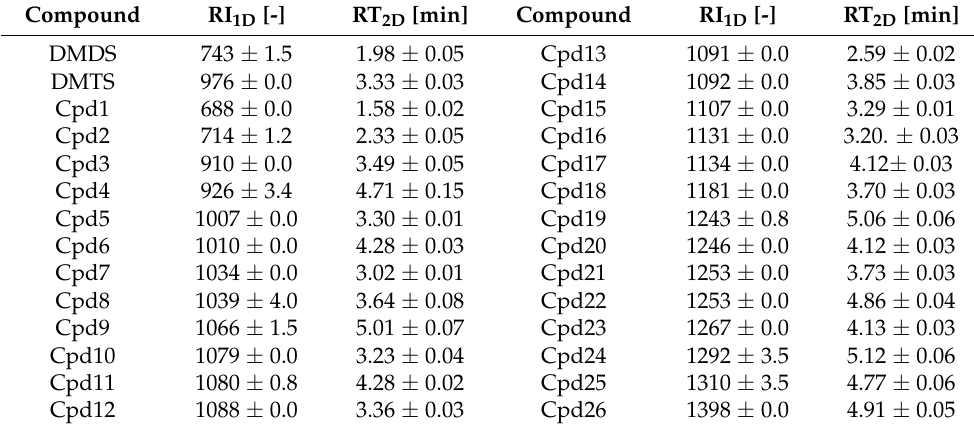
Table 1. Mean retention index (RI 1D ) ± standard deviation on the first dimension and the mean retention time (RT 2D ) ± standard deviation on the second dimension for the 28 detected VSCs. Unidentified compounds are labeled as CpdX, with X increasing in number with increasing RI on the first dimension. Compound RI 1D [-] RT 2D [min]